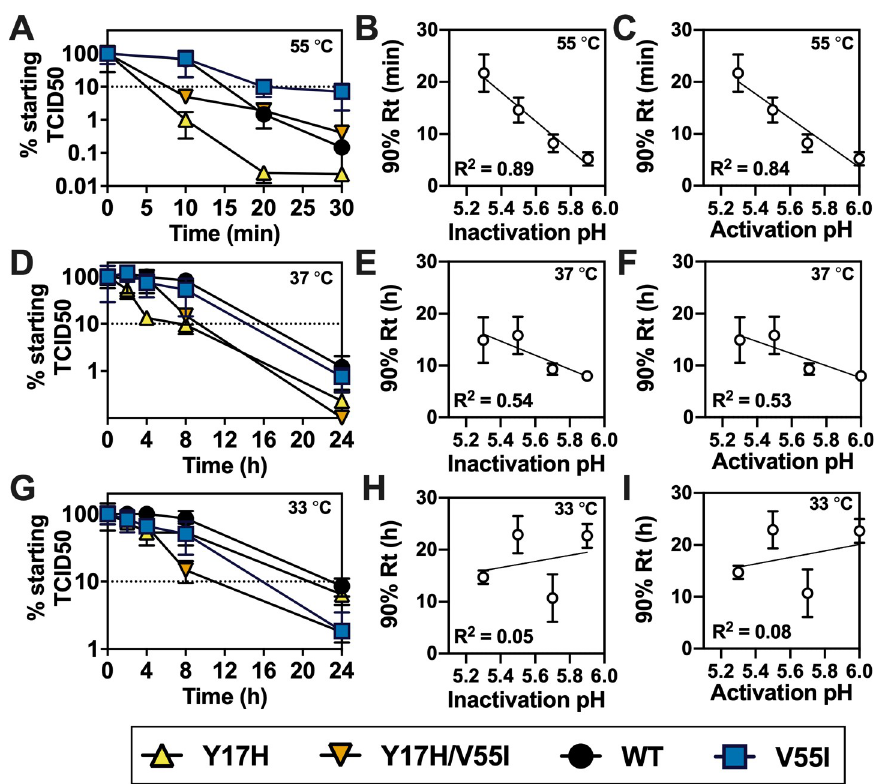
Fig 8. Virus thermostability of A/TN/09 variants and its relationship to pH stability. Residual infectivity (normalized TCID50) was determined for virus-containing aliquots incubated at pH 7.0 for the reported times at 55˚C (A), 37˚C (D), and 33˚C (G). Viruses are Y17H (yellow triangles), Y17H/V55I (orange triangles), WT (black circles), and V55I (blue squares). Virus numbers are 1–4. The 10% (dotted) line corresponds to a 90% reduction of starting infectivity. Virion inactivation pH and HA activation pH values are compared to calculated 90% Reduction time (Rt) values measured at 55˚C (B-C), 37˚C (E-F), and 33˚C (H-I). Representative data from a repeated experiment is shown. Data were analyzed by simple linear regression using GraphPad Prism 8 and calculated R 2 values are reported in the bottom-left corners. R 2 = 0.19). Fig 9 groups the viruses into triplets for ease of analysis: (A) H1N1 with similar acti- vation and inactivation pH values, (B) H3N2 with similar activation and inactivation pH val- ues, (C) H1N1 with HA activation higher than virus inactivation pH, and (D) H3N2 with HA activation higher than virus inactivation pH. Triplet A contained swine H1N1 viruses A/ swine/Nebraska/4G-0314-P18/2014 (virus #37, activation pH 5.2, inactivation pH 5.1), A/ swine/Wisconsin/1/1961 (#23, 5.5, 5.6), and A/swine/Minnesota/27/1976 (#25, 5.7, 5.7). In this group, viruses 25 and 37 had similar thermal inactivation kinetics but differed by approxi- mately 0.5 pH units in pH stability (Fig 9A). Triplet B contained swine H3N2 viruses A/swine/ Minnesota/4157/2010 (#42, 5.4, 5.2), A/swine/Arizona/0934/2011 (#49, 5.5, 5.4), and A/swine/ Ohio/3987/2010 (#38, 5.9, 5.7). The least acid-stable virus (#38) was inactivated the quickest at 55˚C as might be expected; however, virus #42 was more acid stable than virus 49 but was shorter lived at 55˚C (Fig 9B). Triplets C and D contained swine IAVs that had HA activation pH values 0.2–0.4 units higher than virion inactivation pH. Triplet C contained swine H1N1 viruses A/swine/Wisconsin/11/1980 (#28, 5.6, 5.2), A/swine/California/T9001707/1991 (#31, 5.7, 5.3), and A/swine/Italy/1369-7/1994 (#32, 5.9, 5.6). The most acid-stable virus (#28) was shorter lived at 55˚C than the other two (Fig 9C). Triplet D contained A/swine/Oklahoma/